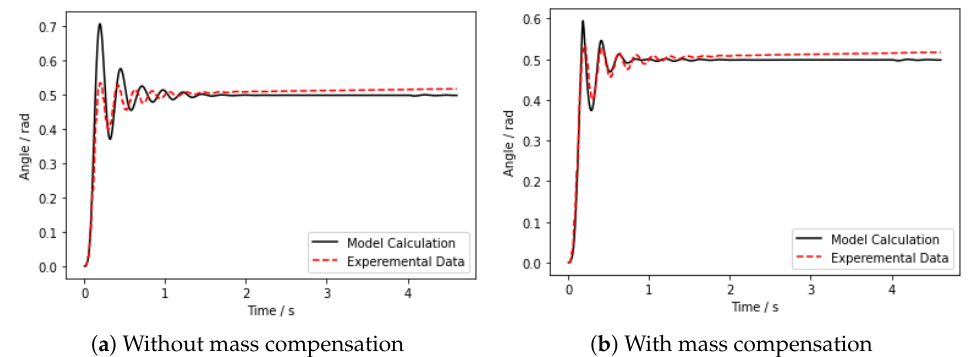
Figure 6. Comparison of results with experimental data under different damping compensation (after damping